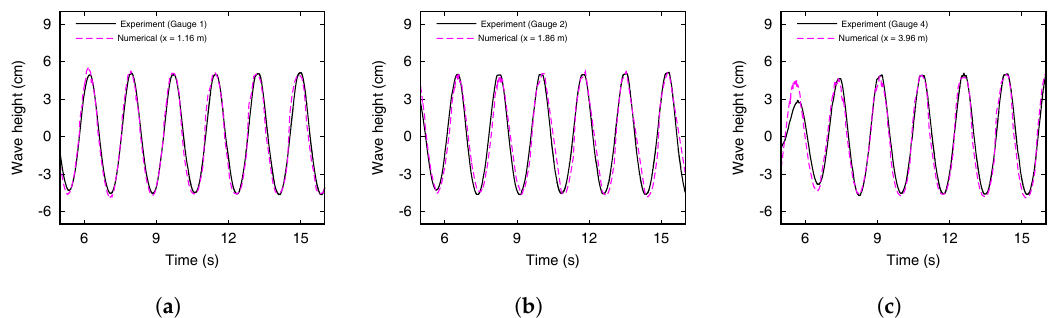
Figure 13. Comparison of the numerical and experimental wave heights ( a ) at x = 1.16 m, ( b ) x = 1.86 m, and ( c ) x = 3.96 m (Case